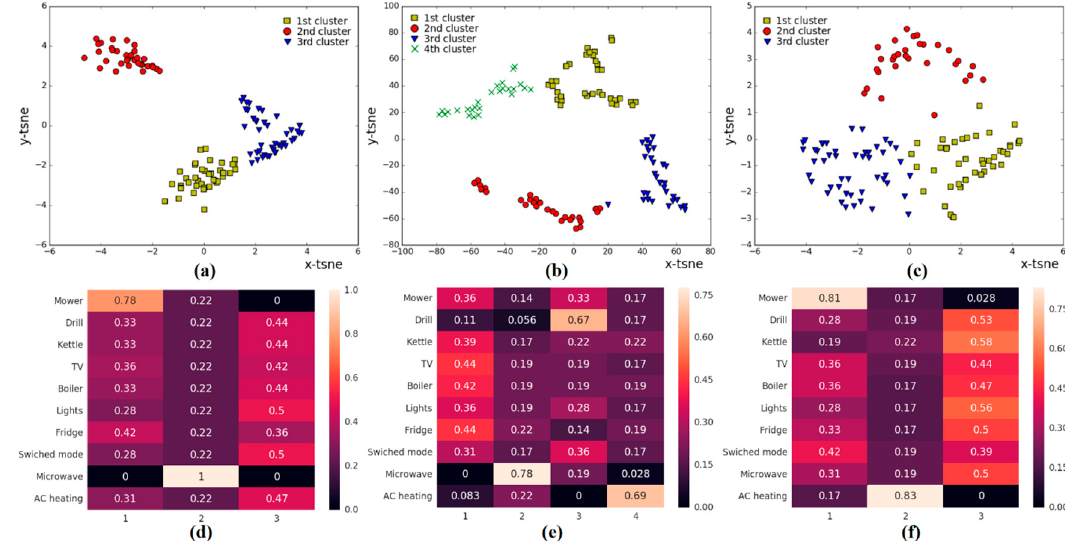
Figure 7. Clustering solutions of PQ parameters progresses at SoC 100% with the calculated probabilities of appliances being part of the particular cluster: ( a , d )—voltage frequency (FREQ) with appliance probabilities, ( b , e )—total harmonic distortion of voltage (THDV) with appliance probabilities and ( c , f )—V with appliance probabilities.